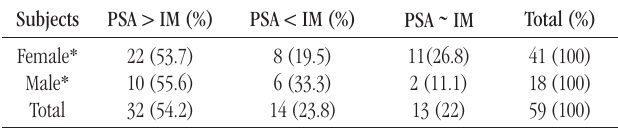
taBLE 3 − Patients ( n = 59) with atrophic body gastritis presenting simultaneously intestinal metaplasia and PSA in atrophic gastric mucosa. Comparative amount of metaplastic glands Subjects